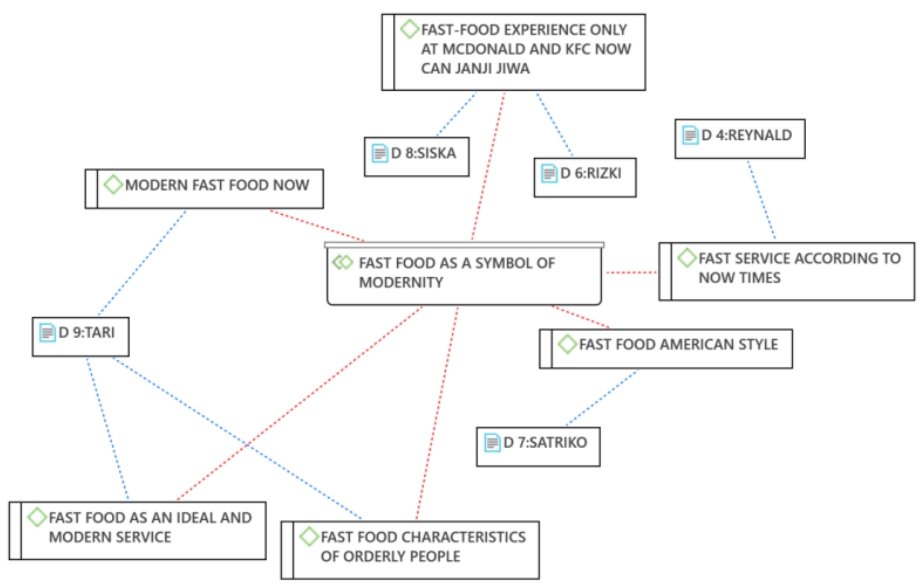
Fig. 2 Fast Food as a symbol of